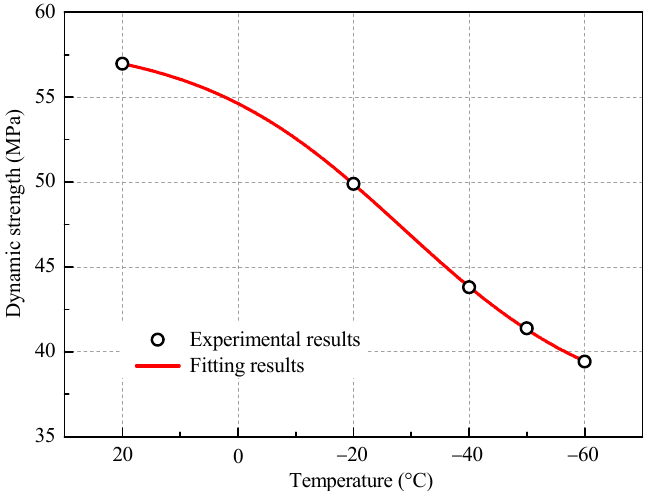
Figure 8. Variation of dynamic strength with freezing temperature.